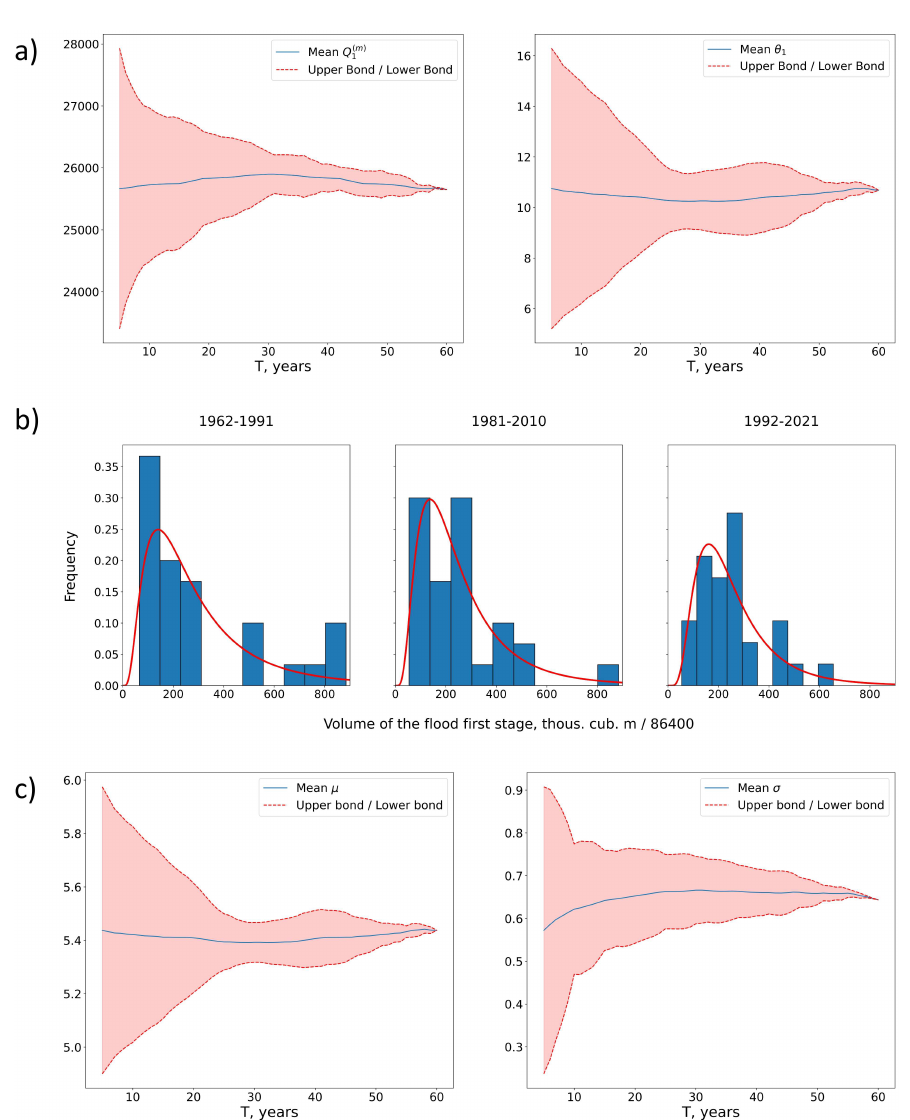
Figure 12. ( a ) Dependences of the values and confidence intervals of the hydrograph parameters for the Volgograd HPP at the first stage on T for 1962–2021; ( b ) coefficients of lognormal distributions of the normalized volume of flood waters; ( c ) examples of frequency distributions for T =